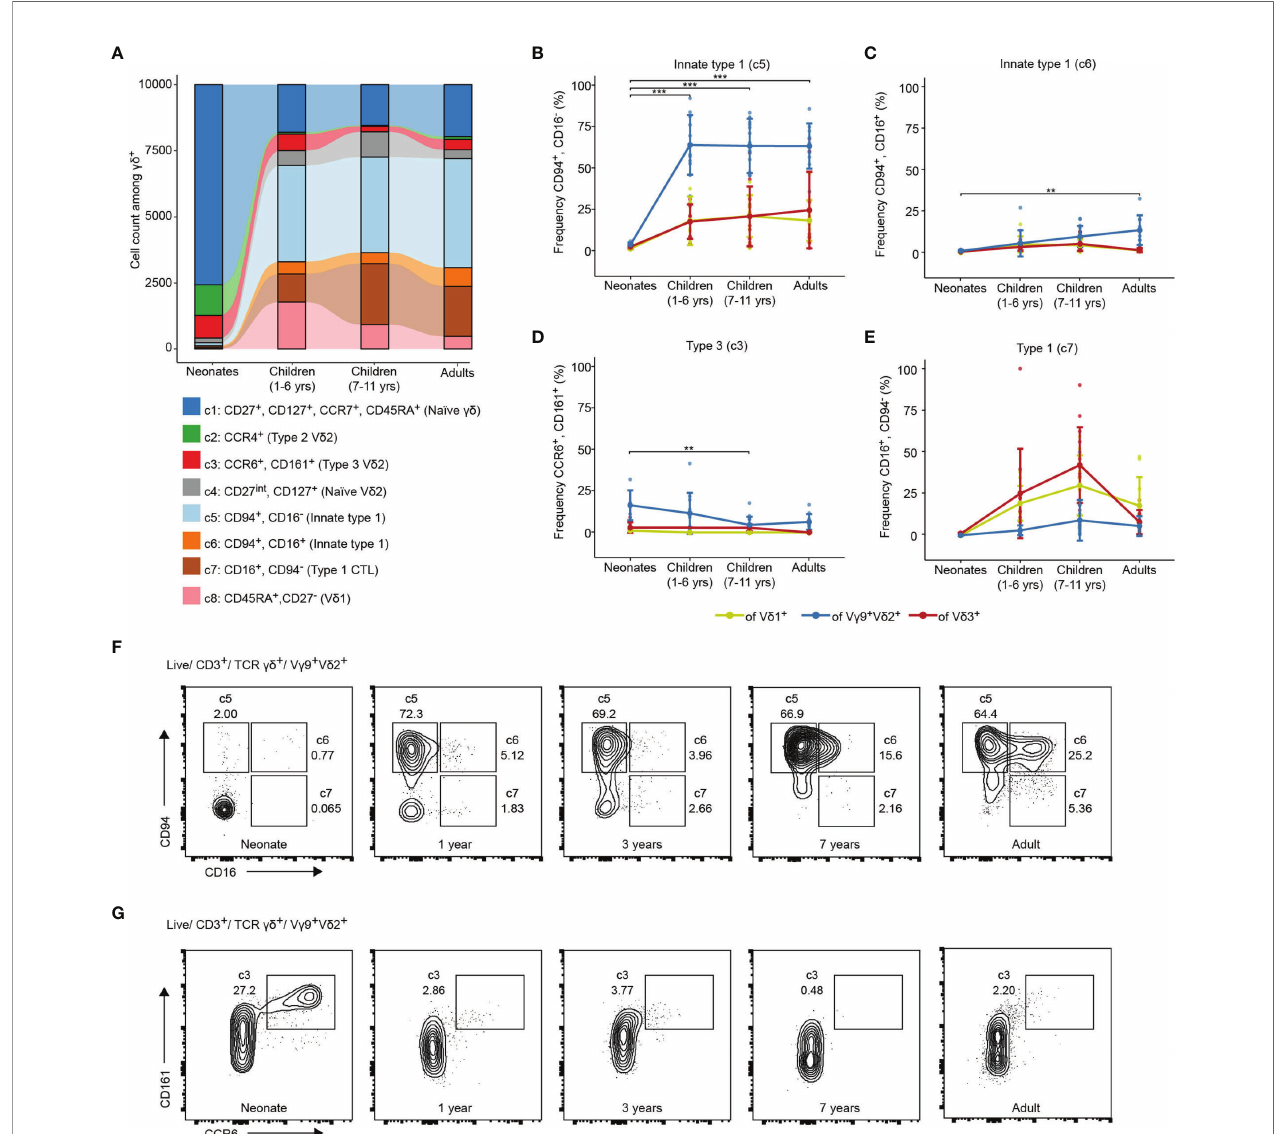
FIGURE 2 | gd T cells show adult-like type1-phenotype in young and older children living in endemic malaria settings. (A) Cell count of the clusters identi fi ed from total gd T cells of newborns (cord blood, n=6), young children (1-6 year old, n=12), older children (7-11 years old, n=15) and adults (n=10). Frequencies of (B) CD94 + /CD16 - ; (C) CD94 + /CD16 + ; (D) CCR6 + /CD161 + or (E) CD16 + /CD94 - gd T effectors of the total V d 1 + , V g 9 + V d 2 + or V d 3 + T cells in newborns (cord blood, n=6), young children (1-6 year old, n=12), older children (7-11 years old, n=15) and adults (n=10). Error bars indicate mean ± SD. Results of V g 9 + V d 2 + comparisons by Tukey post-hoc test after ANOVA are shown. **p < 0.01, ***p < 0.001. Flow cytometric plots of (F) CD94/CD16 and (G) CD161/CCR6 on V g 9 + V d 2 + T cells in representative samples from a neonate, children without malaria aged 1, 2 and 7 years and one